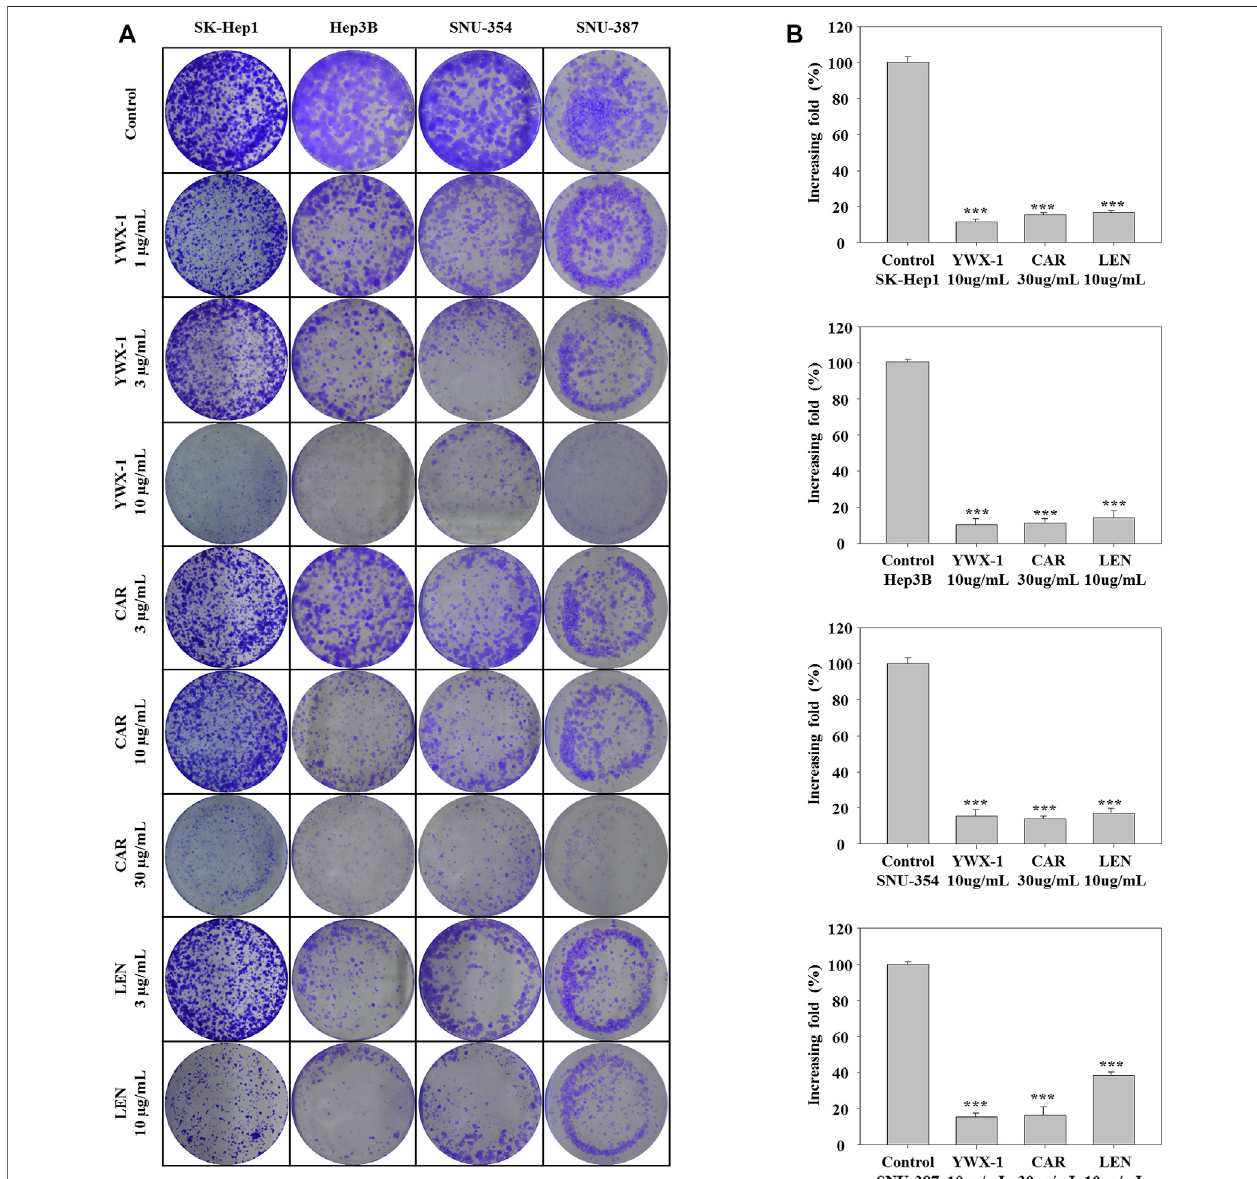
FIGURE 2 | Carrimycin (CAR) and monomeric isovalerylspiramycin I (YWX-1) inhibit the colony formation of hepatocellular carcinoma cells. (A) SK-Hep1, Hep3B, SNU-354, and SNU-387 cells were treated with different concentrations of carrimycin and monomeric isovalerylspiramycin I. Cell proliferation was measured by colony formationassay. (B) Statisticallysigni fi cantdifferencesareindicatedwhencomparedwithcontrolgroup:* p < 0.05,** p < 0.01,*** p < 0.001,Datarepresentedasmean ± standard deviation of three independent experiments (n (cid:2) 3).